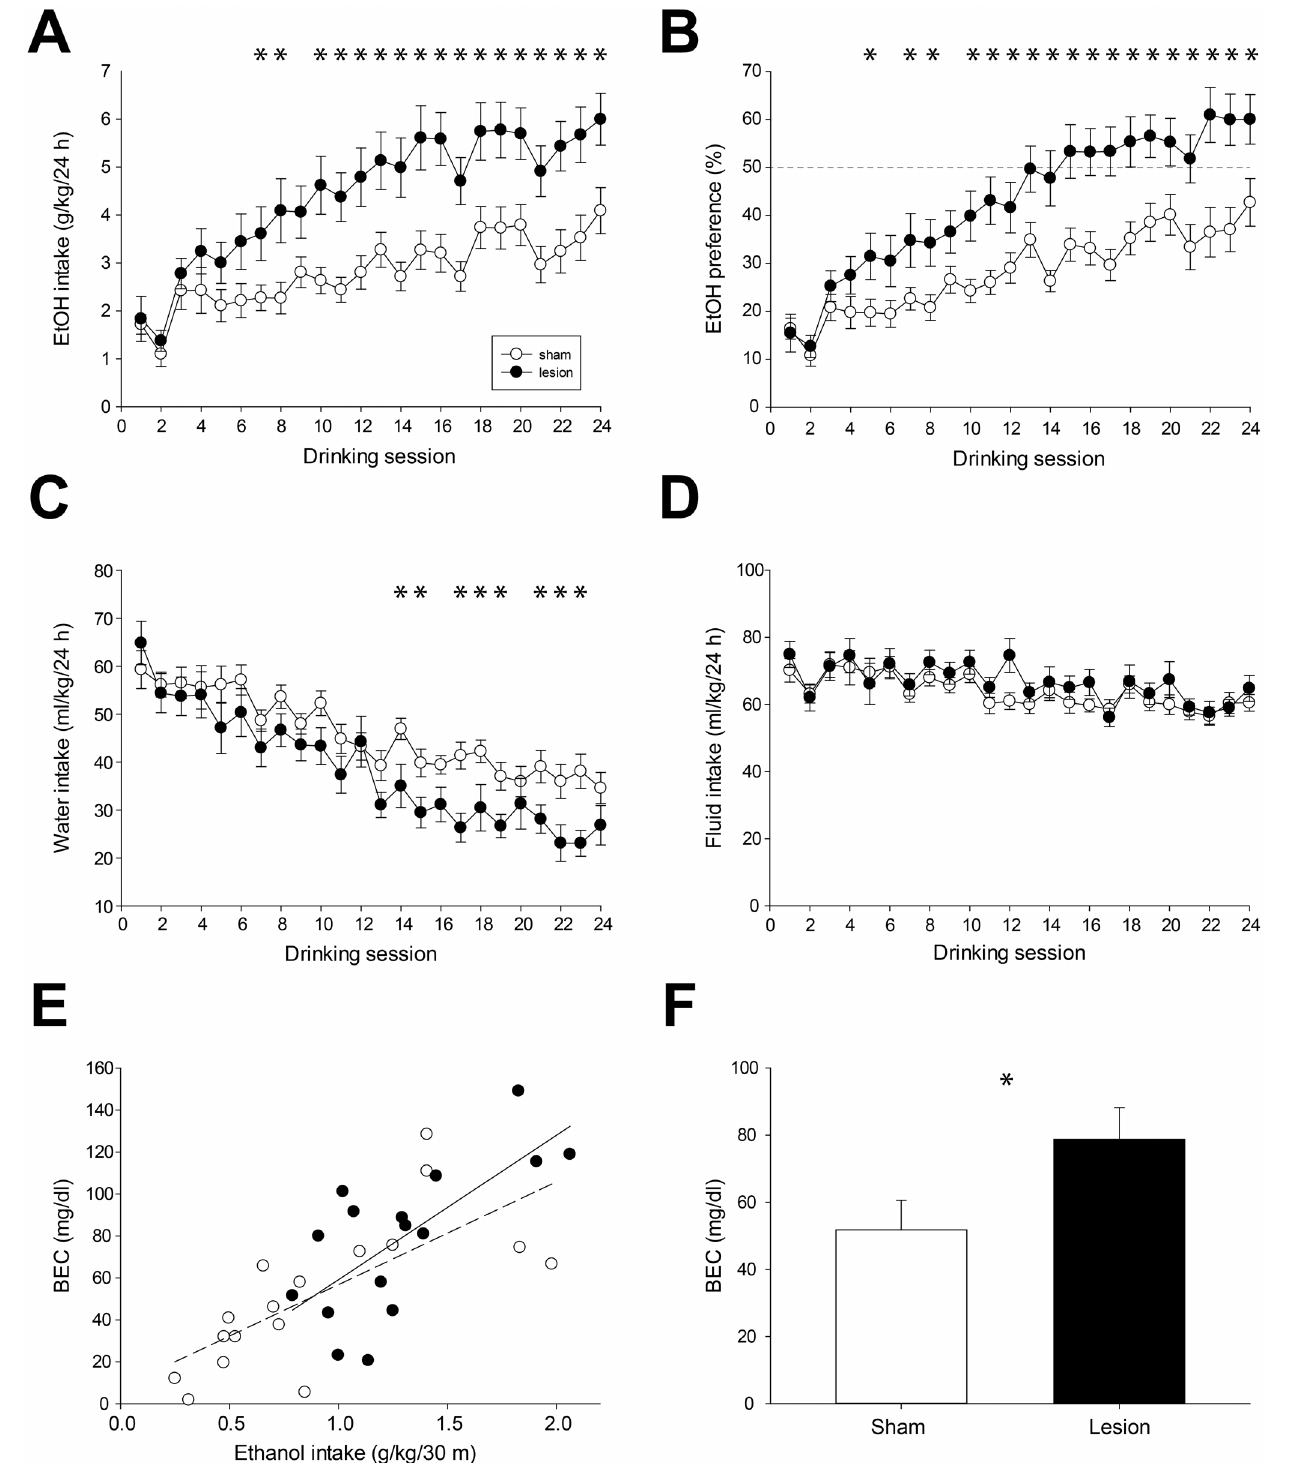
Figure 1. Voluntary ethanol consumption during intermittent access . (A) Lesioned rats consumed significantly more 20% ethanol over the course of 2-bottle choice drinking sessions (3 sessions/week for 8 weeks, 24 sessions total). Symbols indicate mean ethanol intake 6 SEM. In this figure and Figures 2–5, filled symbols indicate lesioned animals, open symbols indicate sham animals, and asterisks indicate significant differences (p , 0.05). (B) Alcohol preference in lesioned rats was significantly higher than that in sham rats. (C) Water intake decreased progressively in both groups, and rats in the lesioned group consumed significantly less water starting in the 5 th week (14 th session) of the paradigm. (D) Total fluid intake (water + ethanol) did not differ significantly between the two groups. (E) Blood ethanol concentrations (BECs) were significantly correlated with voluntary ethanol intake for both groups. Broken line indicates linear fit for sham group; solid line indicates linear fit for lesioned group. (F) Mean ( 6 SEM) BEC measured after the first 30 minutes of 20% ethanol access was significantly higher in lesioned vs. sham rats (p , 0.05). doi:10.1371/journal.pone.0092701.g001 PLOS ONE | www.plosone.org